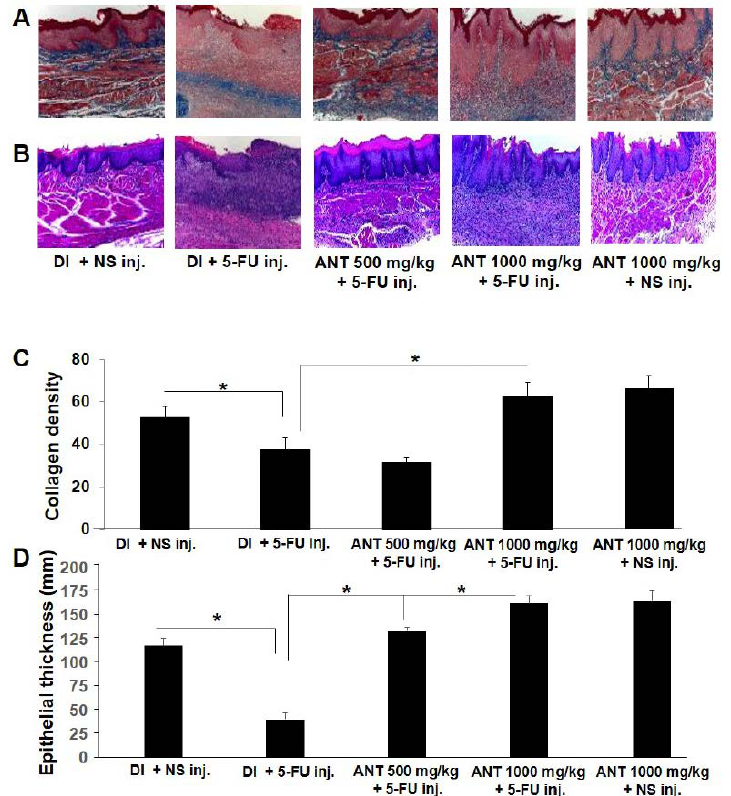
Figure 4. Histological examination of buccal mucosa in 5-FU induced oral mucositis. ( A ) Mallory’s azan staining; ( B ) hematoxylin and eosin staining. Note that blue indicates collagen bundles stained by Mallory’s azan; original magnification ×40; ( C ) collagen density and ( D ) epithelial thickness were quantitated and data are expressed as mean ± S.D. * p < 0.001.